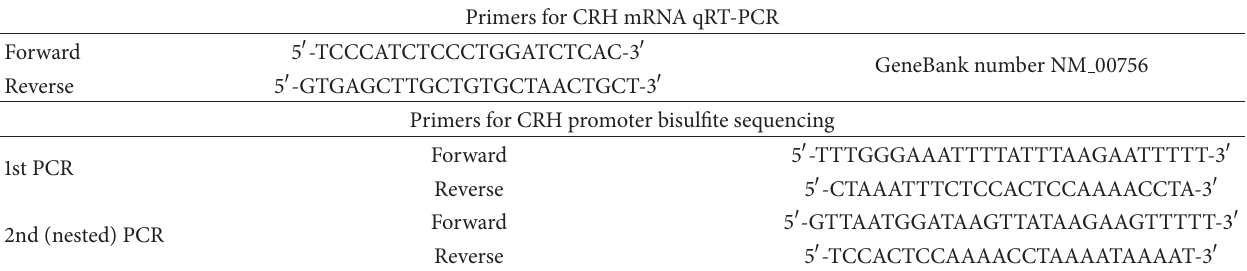
Table 1: Primers used for quantitative real-time RT-PCR (qRT-PCR) and bisulfite sequencing. Primers for CRH mRNA